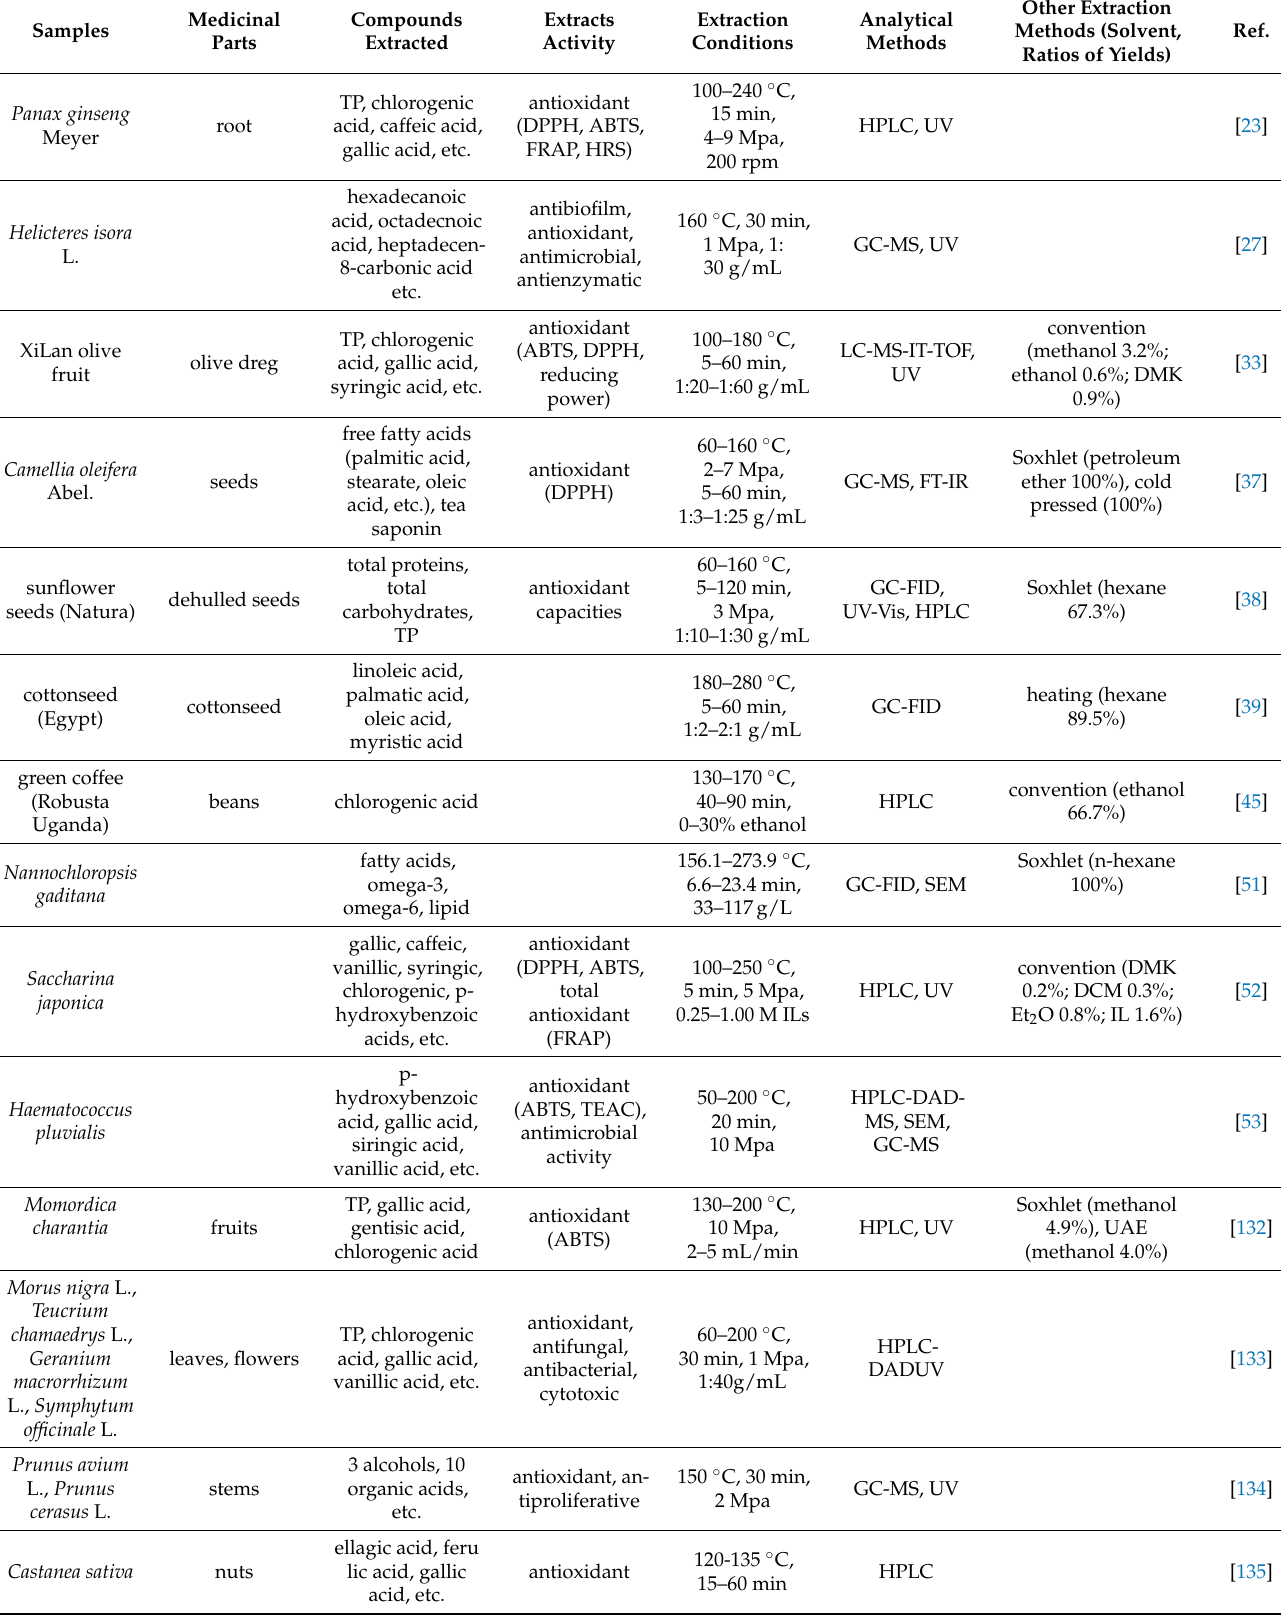
Table 3. Subcritical water extraction of organic